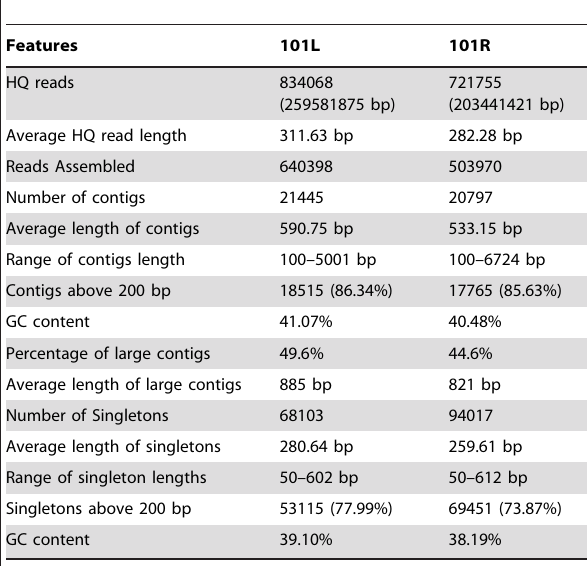
Table 1. Summary of 454 sequencing and assembly for leaf (101L) and root (101R) of Withania